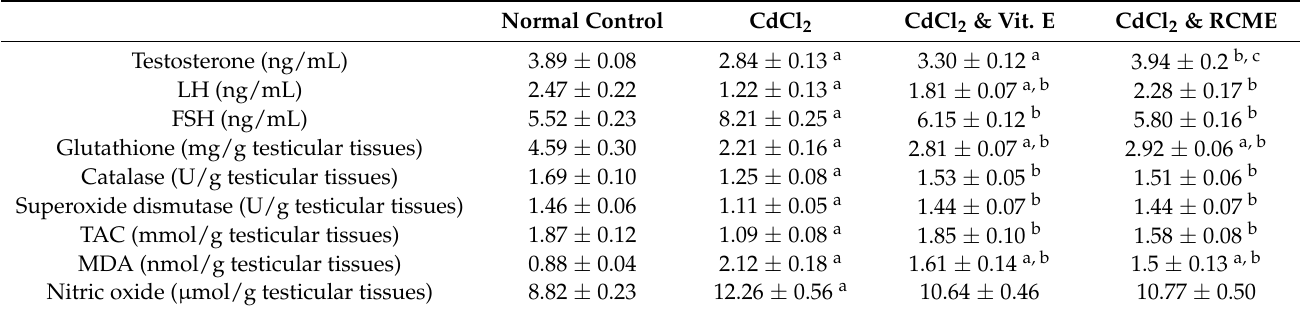
Table 2. Biochemical analyses in different studied groups. Normal Control CdCl